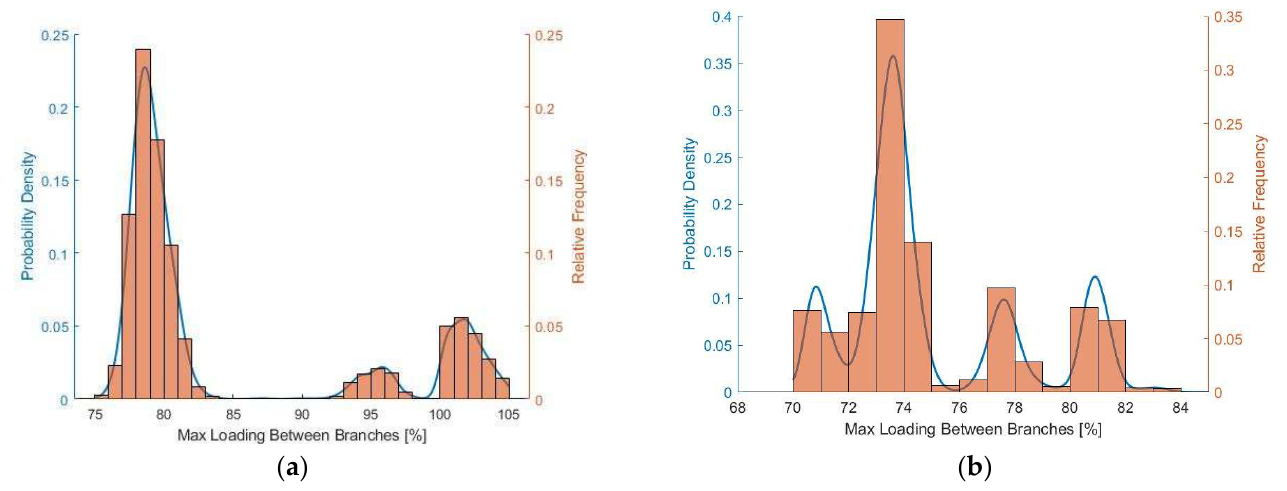
Figure 8. Results of maximum loading when hosting limits are reached: ( a ) P2P case; ( b ) Three-station case.